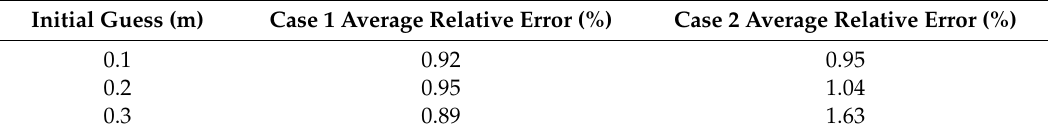
Figure 5. Identification results of di ff erent initial guess boundaries of case 2. Table 1. Impacts of initial guess of cases 1 and